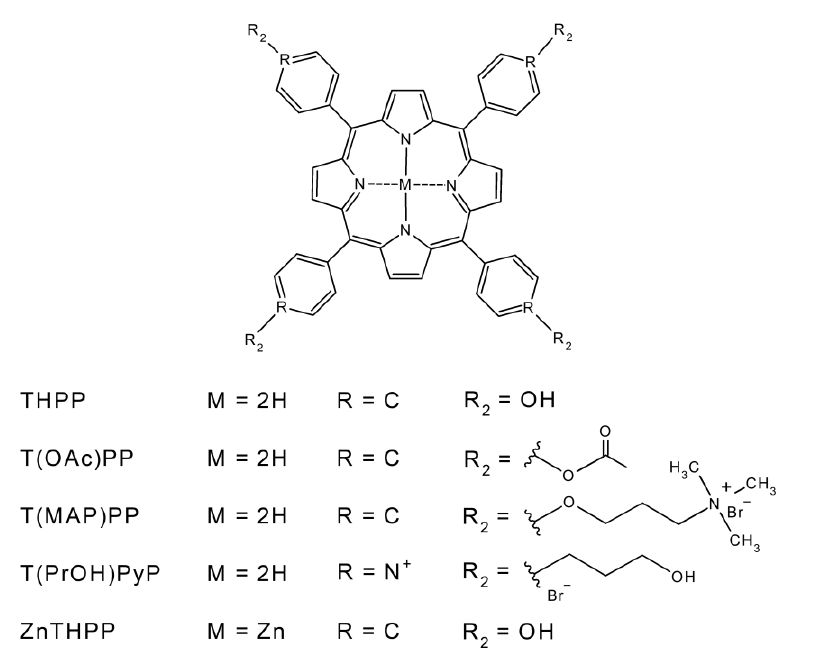
Scheme 1. Structure of the porphyrins used along the present work.